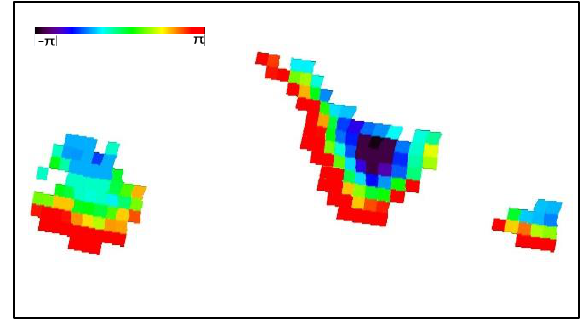
Figure 6. Simulated tropospheric phase delay from MODIS data in RADAR